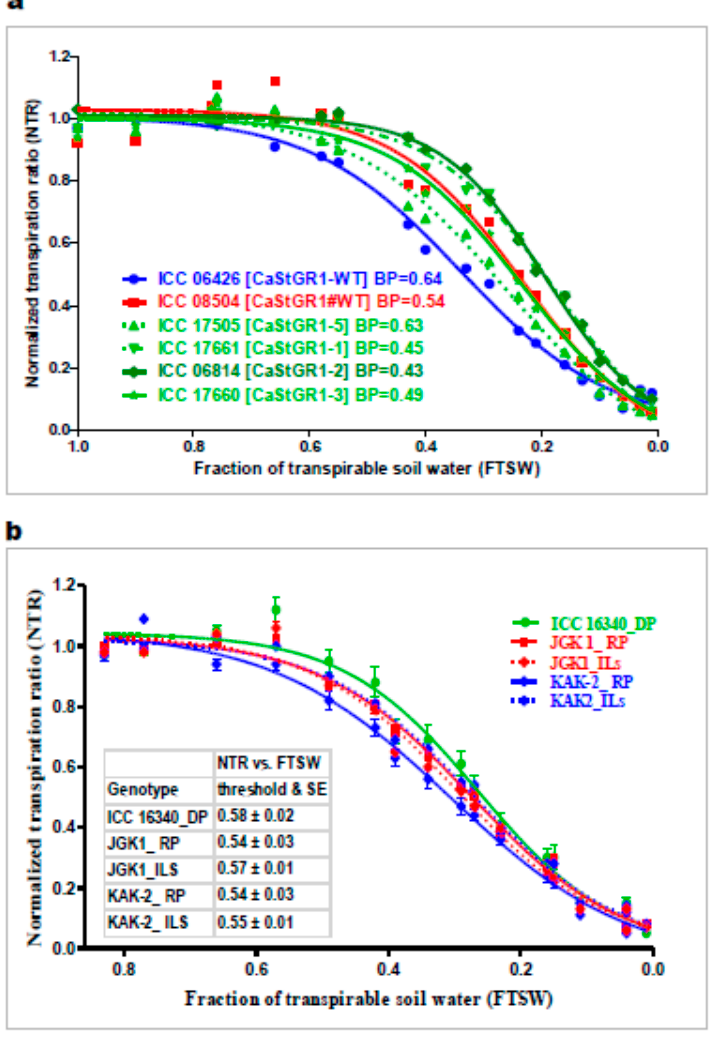
Figure 3. ( a ) Normalized transpiration ratio (NTR) versus fraction of transpirable soil water (FTSW) of chickpea genotypes differed in deletion of CaStGR1gene segments [ICC 08504-CaStGR-1-#Wild type (filled square with solid red line); ICC 06426-CaStGR-1-Wild type (filled round with solid blue line); ICC 17505-CaStGR-1-5 (filled upward triangle with dashed green line); ICC 17661-CaStGR-1-1 (filled down-word triangle with dashed green line); ICC 06814-CaStGR-1-2 (filled diamond with solid green line) and ICC 17660-CaStGR-1-3 (open round with solid green line)] exposed to progressive drying soil under glasshouse conditions. During detached leaf green assay, ICC 08504-CaStGR-1-#Wild type showed yellow colour in all leaflets fully. By contrast, ICC 06426-CaStGR-1-Wild type showed semi-green colour leaflets. Genotypes with CaStGR1-1 (ICC 17661), CaStGR1-2 (ICC 06814), CaStGR1-3 (ICC 17660), and CaStGR1-5 (ICC 17505) showed completely green colour in all the leaflet during detached leaf green assay. Values are transpiration data of five replicated plants for each genotype at each FTSW condition. The FTSW thresholds where transpiration initiated its decline were calculated with a plateau regression procedure from SAS. The regression lines of the relationships between NTR and FTSW were drawn by fitting NTR to FTSW data above and below the respective threshold for transpiration decline in each genotype with GraphPad Prism. The FTSW breakpoint (BP) are displayed in the figures. ( b ) Normalized transpiration ratio (NTR) versus fraction of transpirable soil water (FTSW) of stay green chickpea introgression lines (ILs) with different genetic background [stay green donor parent (DP) ICC 16,340 (square with solid green line); Recurrent parent (RP) JGK1 (square with solid red line); JGK1 background introgression lines JGK1-ILs (square with dashed red line); Recurrent parent (RP) KAK2